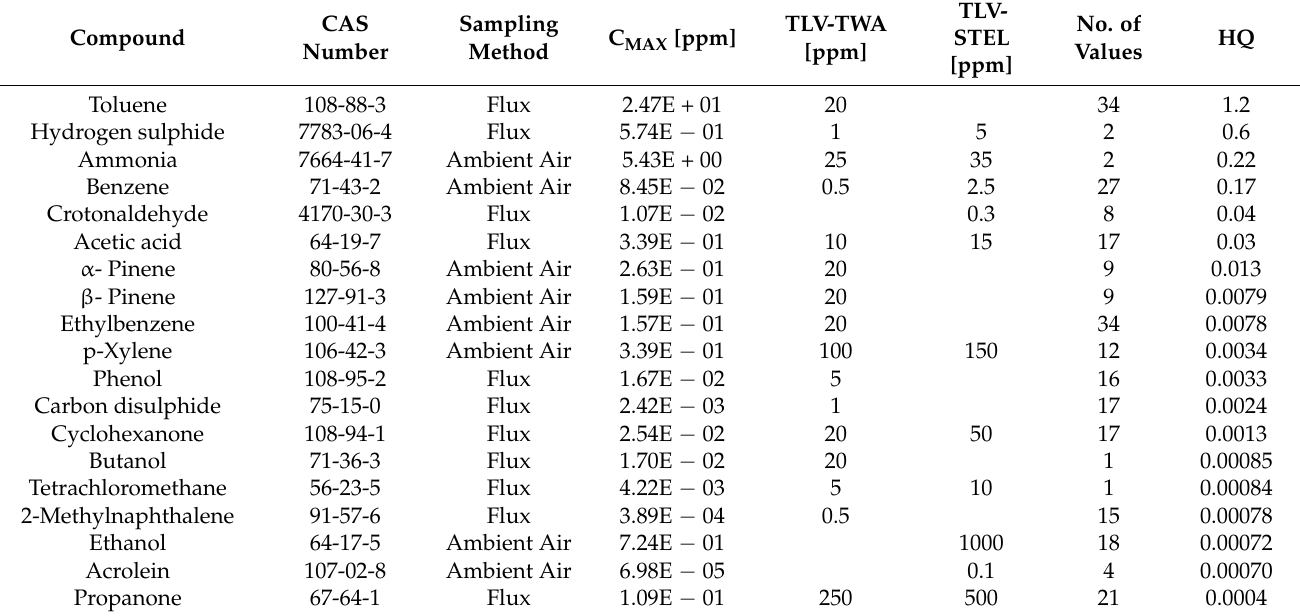
Table 5. Comparison of maximum concentration, sampling method adopted, number of values observed in the literature, TLV and HQ values for compounds found in permanently covered landfill surface